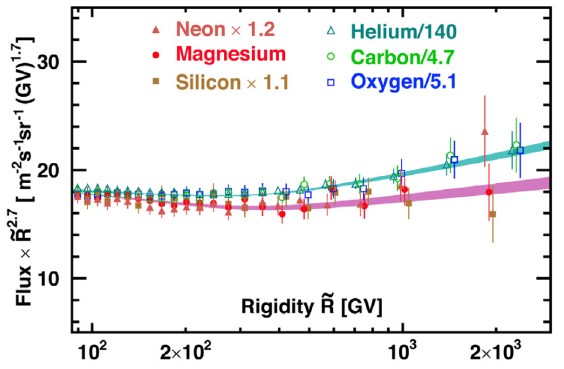
Figure 9. Nickel spectrum measured by CALET